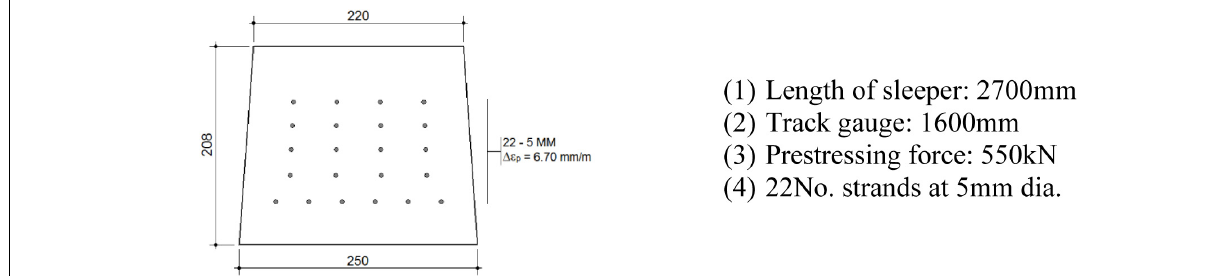
FIGURE 2 | Cross section of railway sleepers (Remennikov et al., 2011).